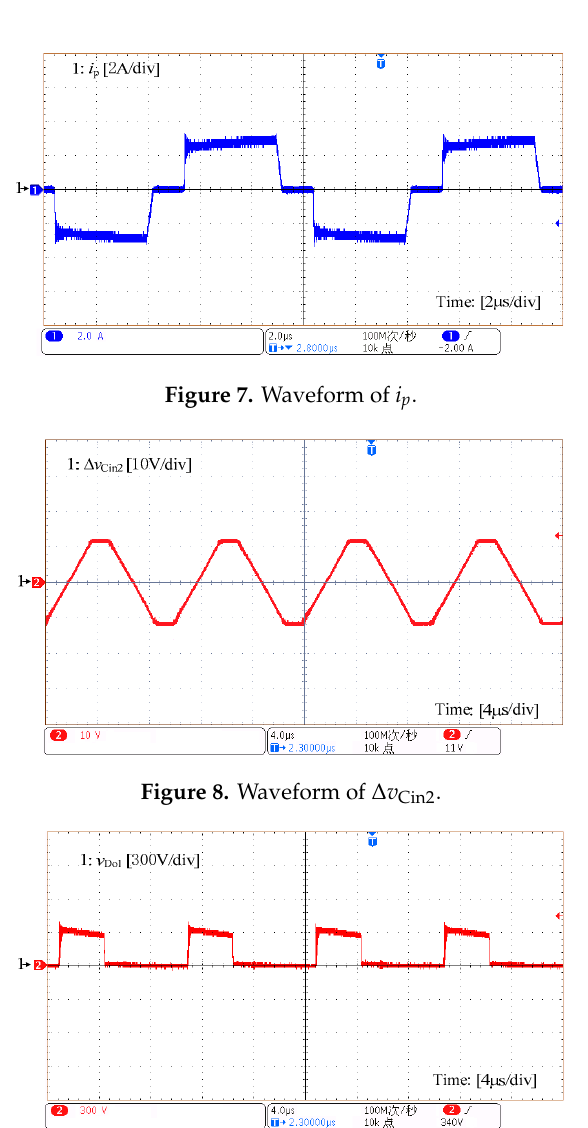
Figure 6. Waveform of v p .